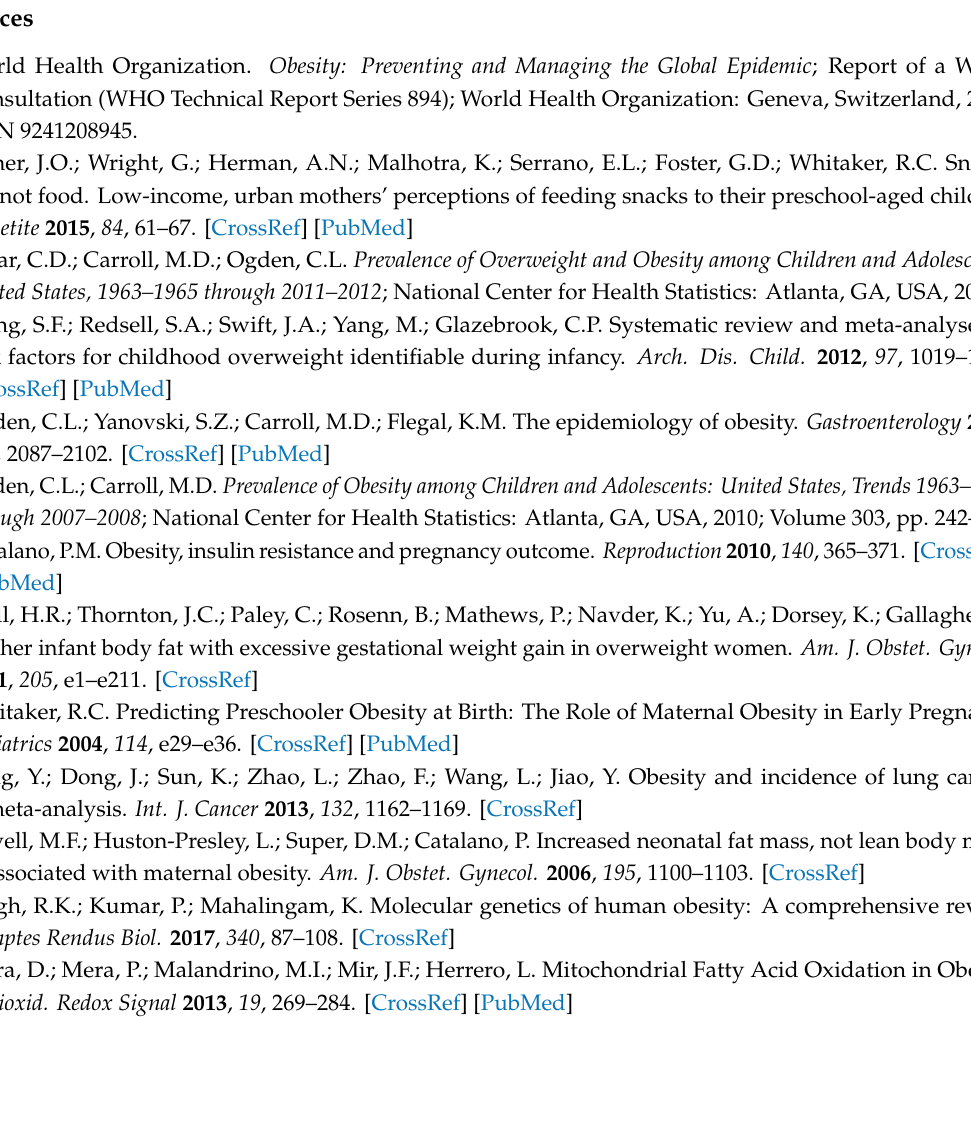
Table S1: Profiles of triglycerides (TGs) (expressed in % of total TG) in blood of male and female o ff spring at day 25 of life and suckled by dams fed Control or Western diet. Figure S1: PLS-DA score plot for 25 data points (SLs), reveals natural clusters for all the male (MC, MWD) and female (FC, FWD) 25 days old-o ff